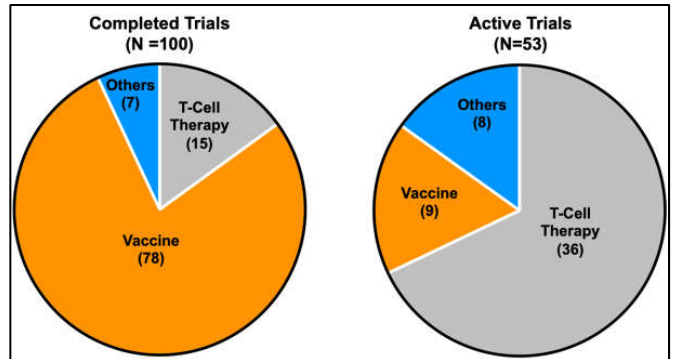
Figure 4. Pie charts indicating the proportion of current therapeutic strategies in completed and active clinical trials targeting CTAs. A gradual shift in the trend from more vaccine-based strategies to T-cell-based strategies is evident from the increase in the proportion of active trials that utilises T-cell-based strategies compared to earlier completed trials.(Information was obtained from https://clinicaltrials.gov, 6 th March 2023).